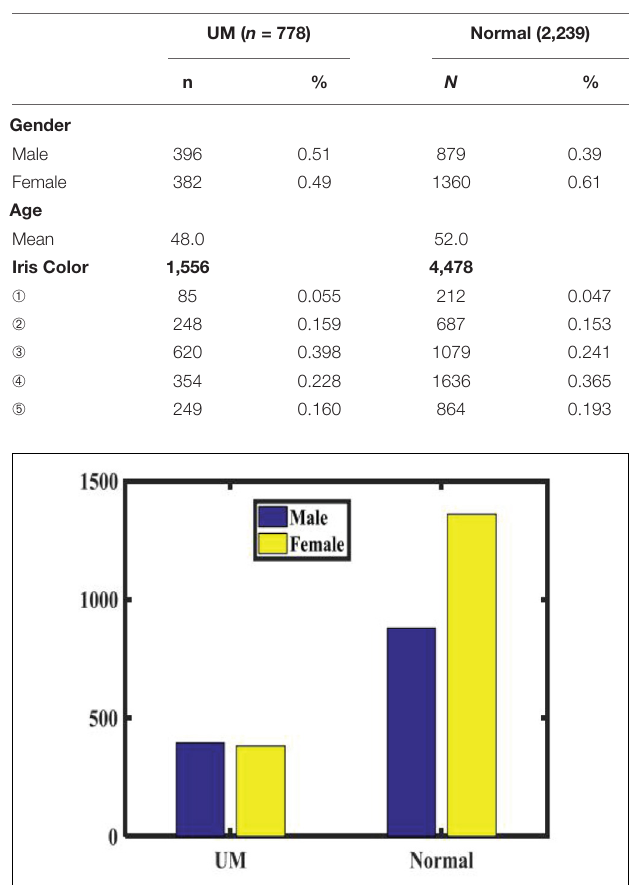
TABLE 1 | Baseline characteristics of the study population.